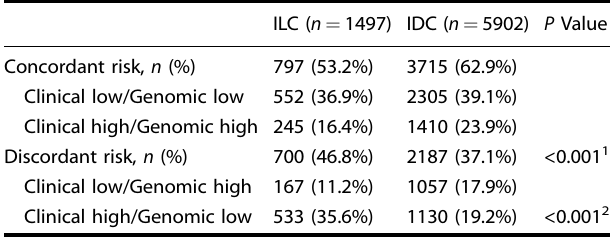
Table 2. Distribution of clinical and genomic risk categories by histology.